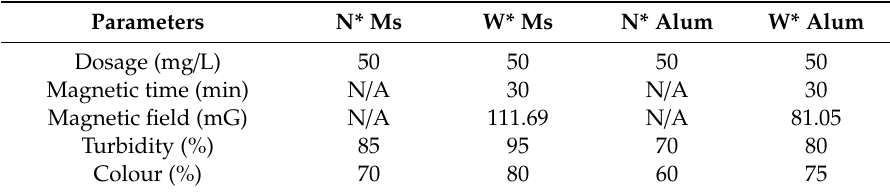
N*—no magnetic field, W*—with magnetic field, N / A—not